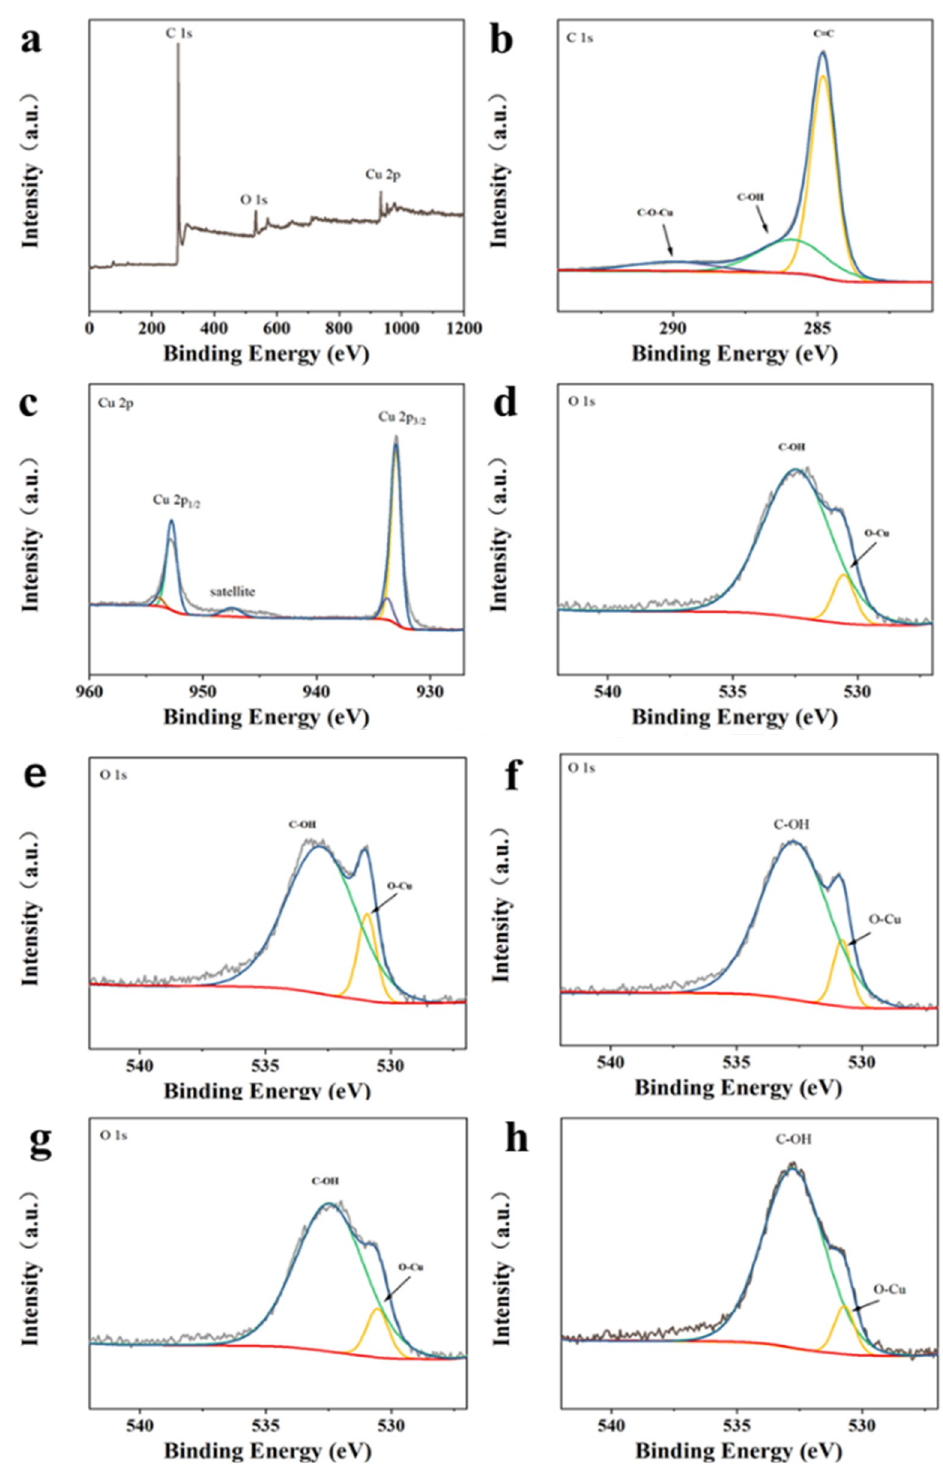
Figure 4. XPS of Cu@C-800 ( a ) full spectrum, ( b ) fine spectrum of C1s, ( c ) fine spectrum of Cu 2p, ( d ) fine spectrum of O1s, the O XPS fine spectrum of ( e ) Cu@C-600, ( f ) Cu@C-700, ( g ) Cu@C-800, ( h ) Cu@C-900.